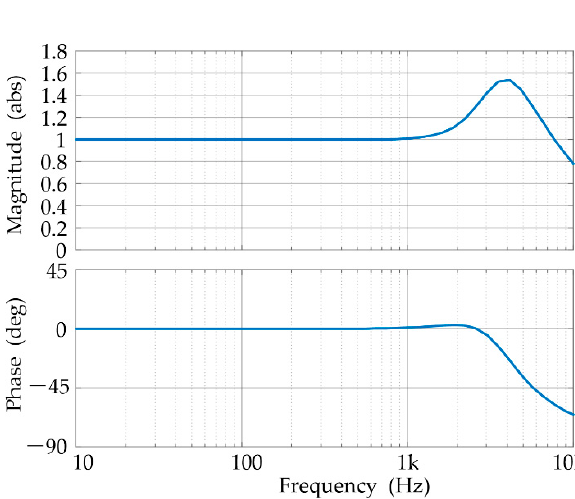
Figure 8. Bode plot of the coefficient G (s).